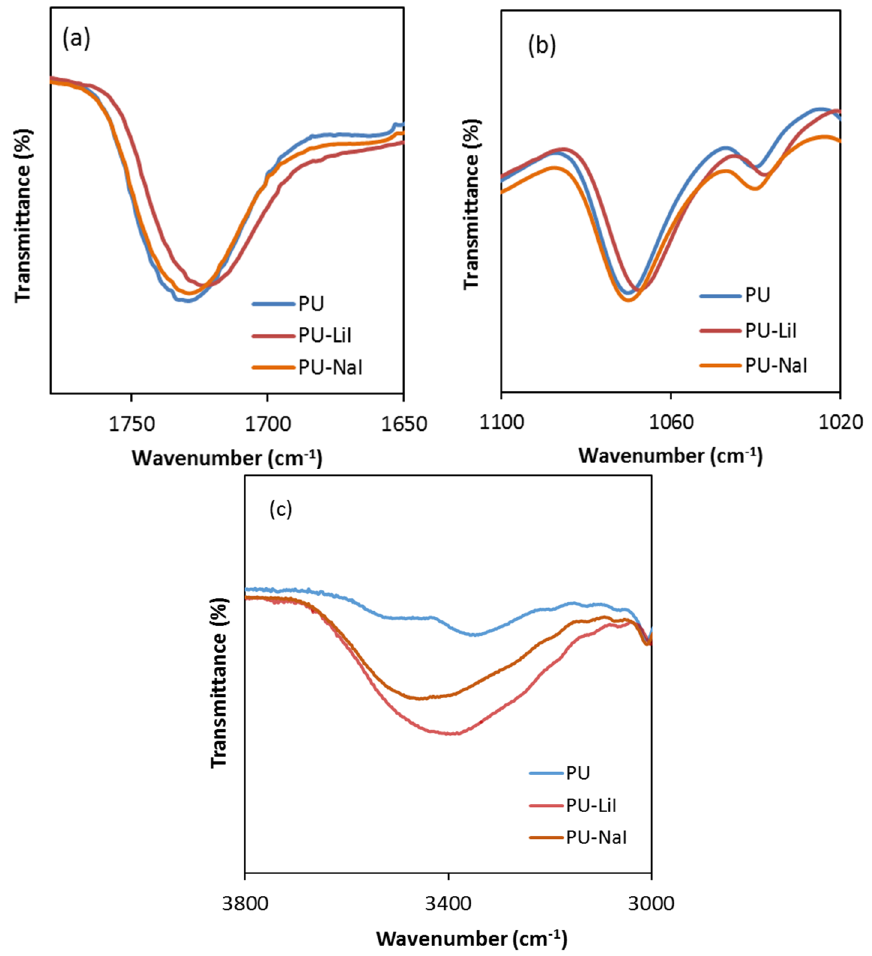
Figure 2. FTIR spectra in ( a ) C=O and ( b ) C–O–C and ( c ) NH vibrational